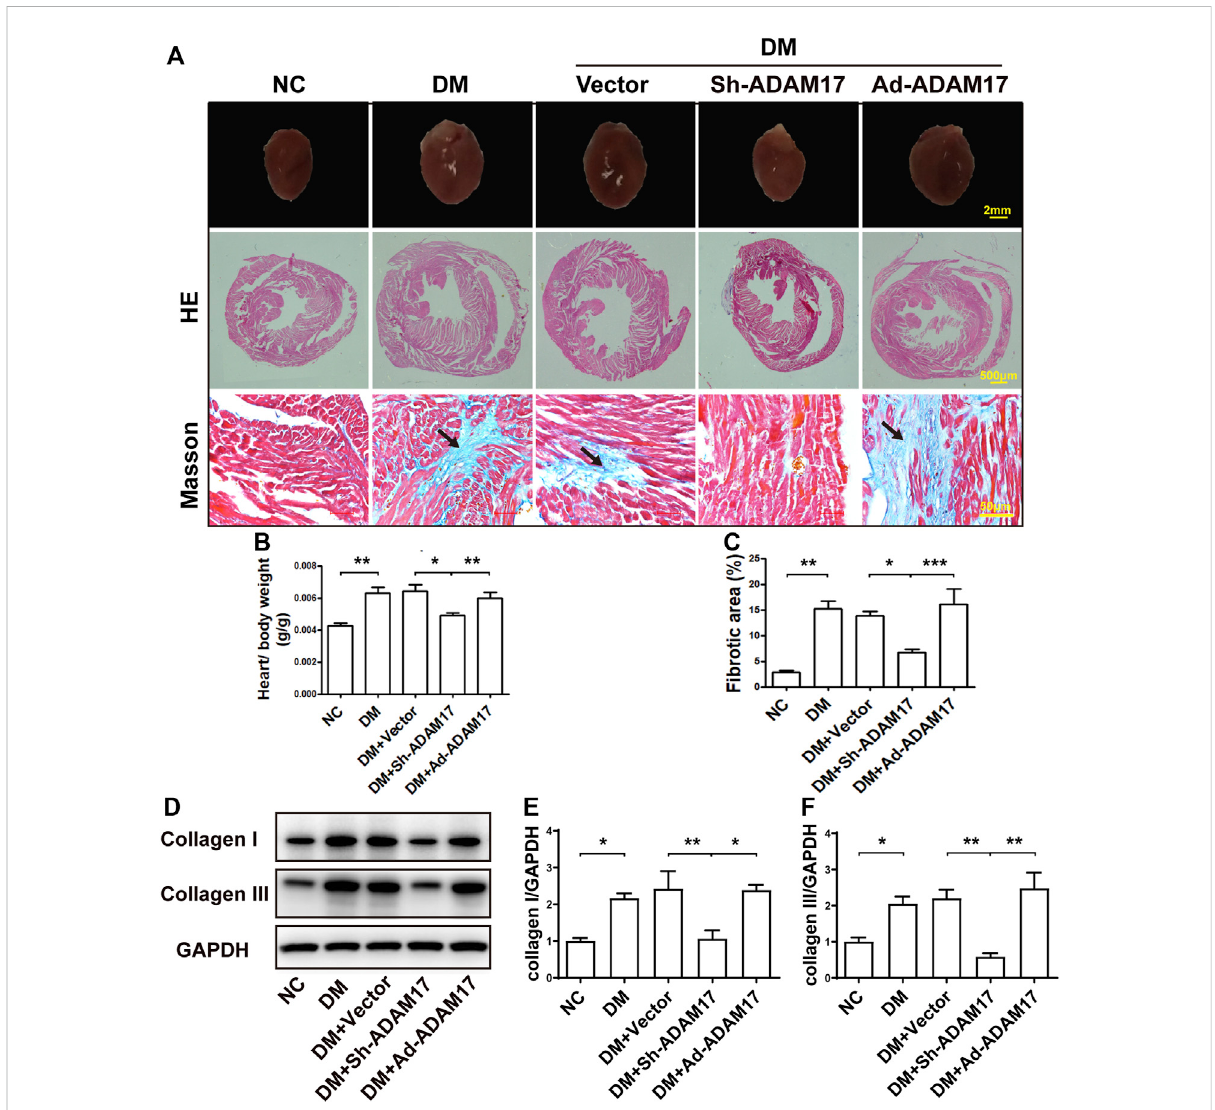
FIGURE 2 Comparison of heart size, cardiac fi brosis and myocardial collagen deposition in 5 groups of mice. (A) Representative images of cardiac cross sections( fi rstrow;scalebar:2 mm),hematoxylinandeosin(HE)staining(secondrow,40x,scalebar:500 μ m;thirdrow,400x,scalebar:50 μ m)and Masson ’ s trichrome staining (fourth row; 400x, scale bar: 50 μ m) in 5 groups of mice. (B) Measurements of heart/body weight ratio in 5 groups of mice. (C) Measurementsof fi broticareaincardiaccrosssectionsin5groupsofmice. (D) RepresentativeWesternblotimagesandquanti fi cation of collagen I (E) and III (F) expression in 5 groups of mice. Data were expressed as the means ± SEM. * p < 0.05, ** p < 0.01, *** p < 0.001. n = 6 per